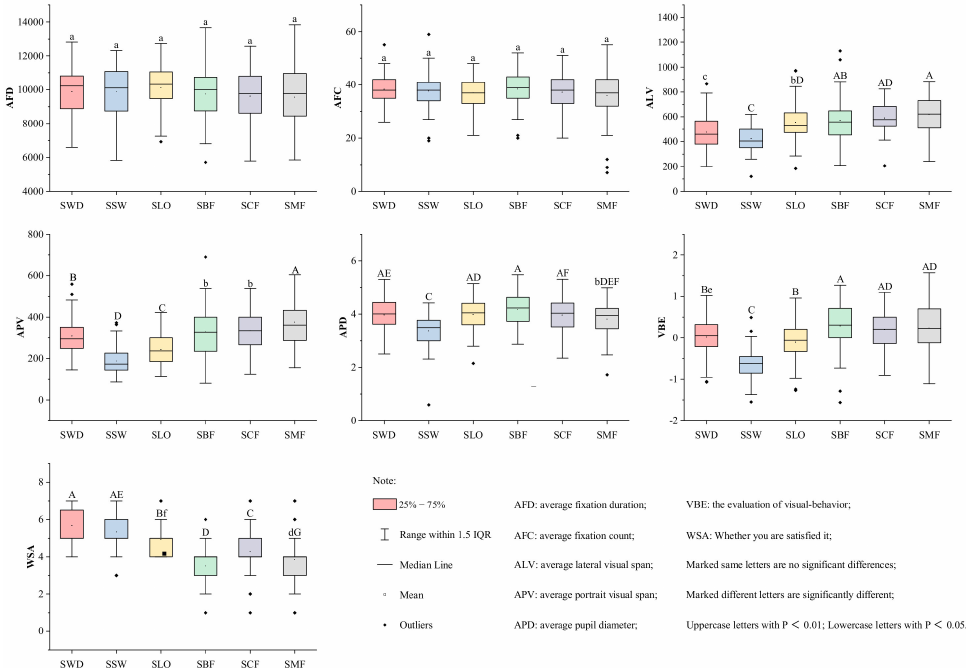
Figure 5. Differences in participant’s visual behavior and satisfaction preference in forest recreational landscape space. This figure was created by Yu Gao (Shenyang Agricultural